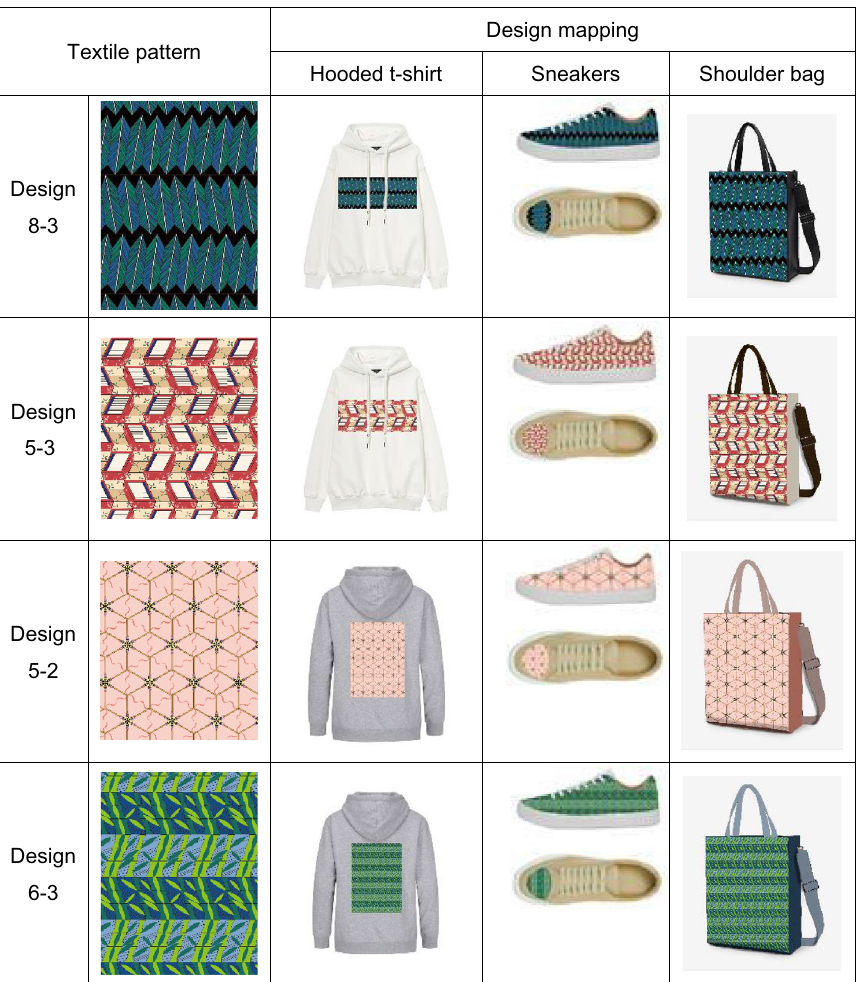
Table 9 Design mapping with a textile pattern design